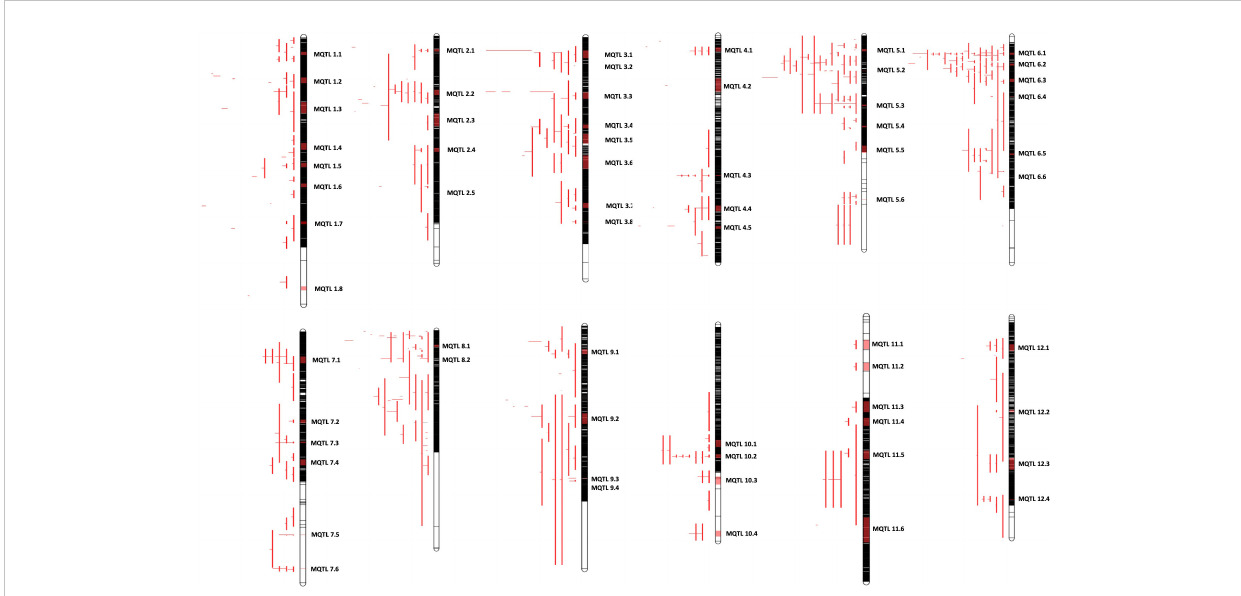
FIGURE 2 Distribution of meta-QTLs on rice chromosomes. Rice chromosomes are represented by the vertical bars. The names of consensus markers along with their position (cM) are present on the right of the chromosomes. QTLs mapped in various studies are highlighted in different colours on the left of the chromosomes. Coloured blocks on the chromosomes represent the identi fi ed meta-QTLs. Vertical bars on the left side of the chromosome represent the con fi dence interval (CI) of QTL and horizontal bars represent the phenotypic variance.